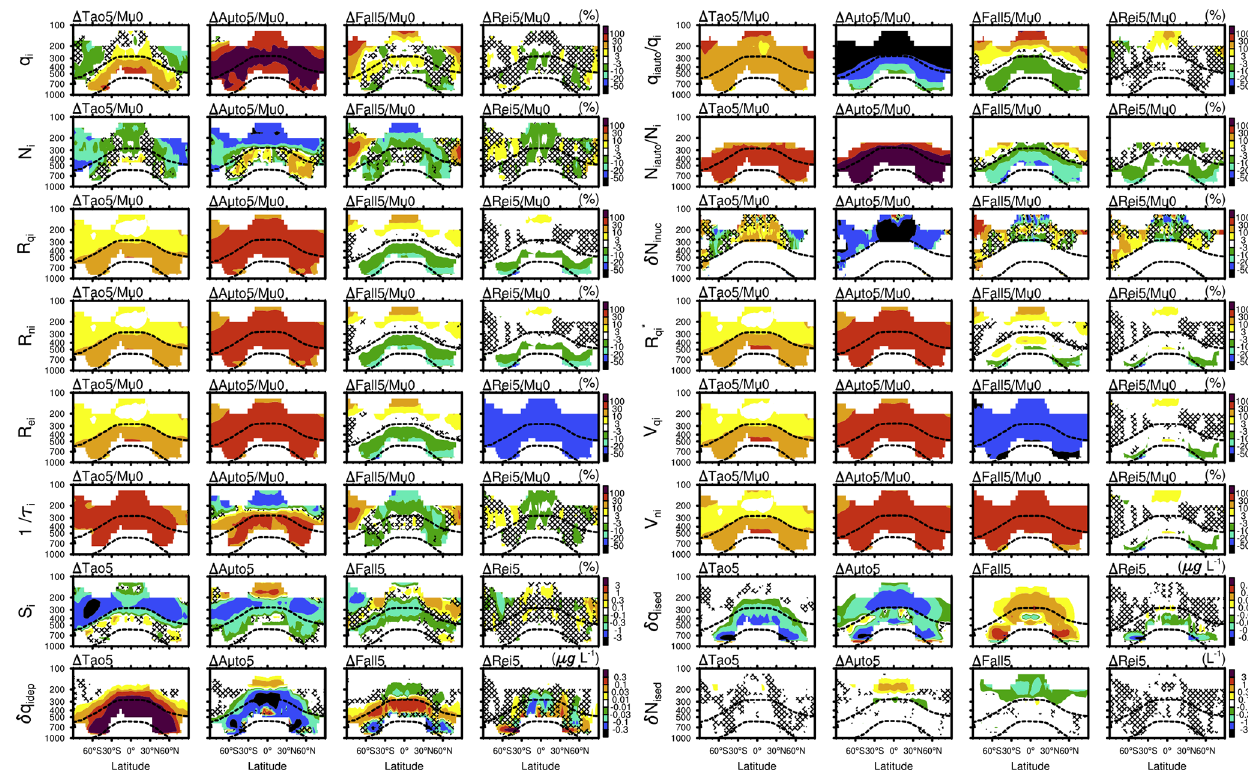
, all statistical mean radii are i